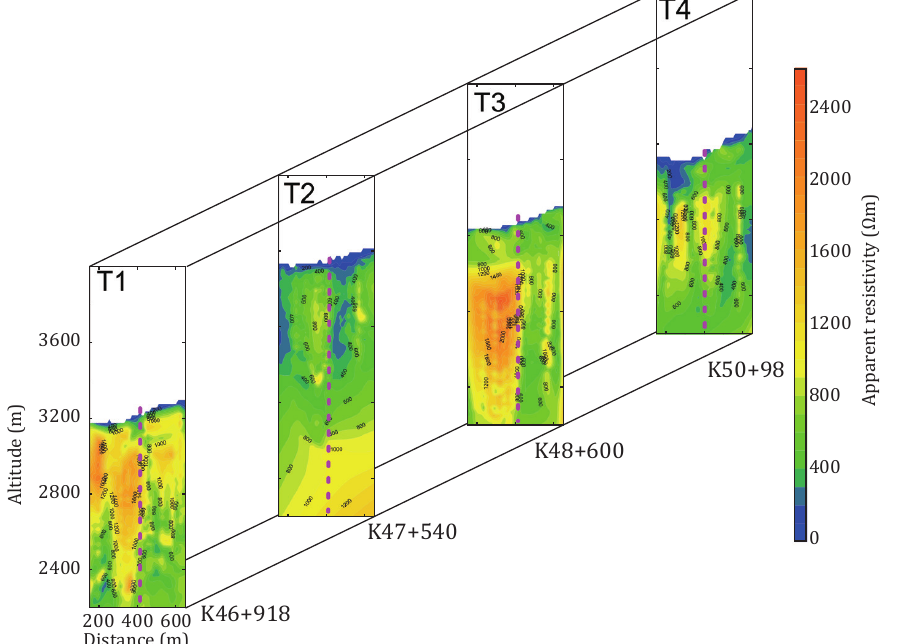
Figure 8. A 3D slice of the apparent